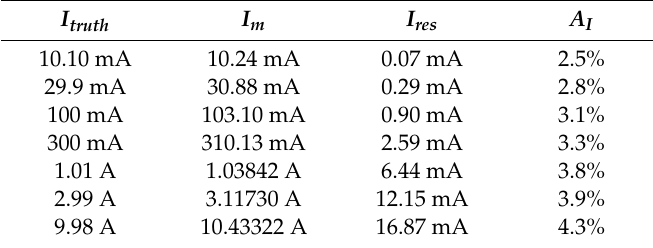
Table 3. Relative error of the proposed current measurement